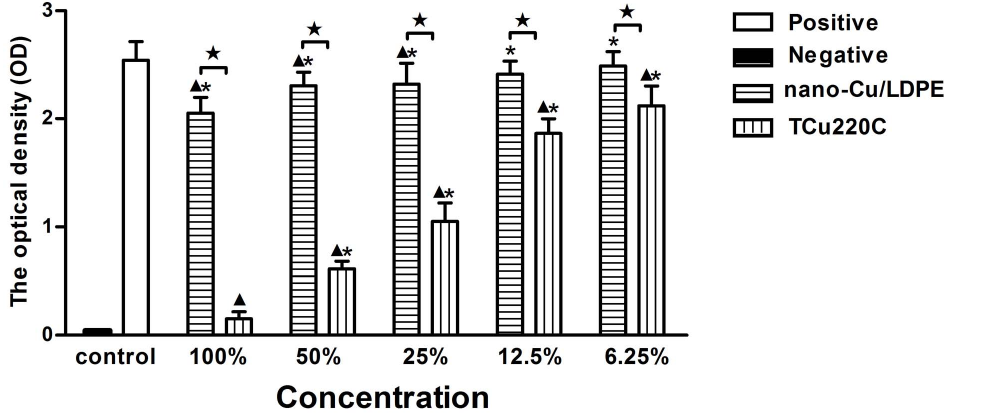
Figure 3. The OD values of the extracts of the nano-Cu/LDPE and TCu220C IUD for 5 d. * p , .05 compared with the positive group; m p , .05 compared with the negative group; w p , .05 between two groups.